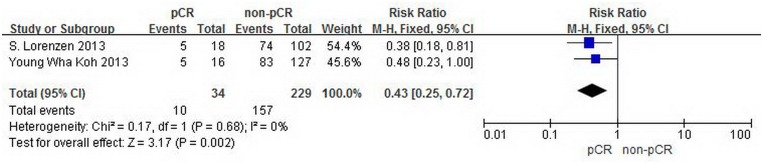
Forest plot of pooled relative risk for three-year DFS from eligible studies.The area of each square represents the weighting, and the positions of each square demonstrate the risk ratio point estimate. Horizontal lines represent 95% confidence interval (CI). M-H = Mantel-Haenszel. Events = recurrence or metastasis happened within three years.